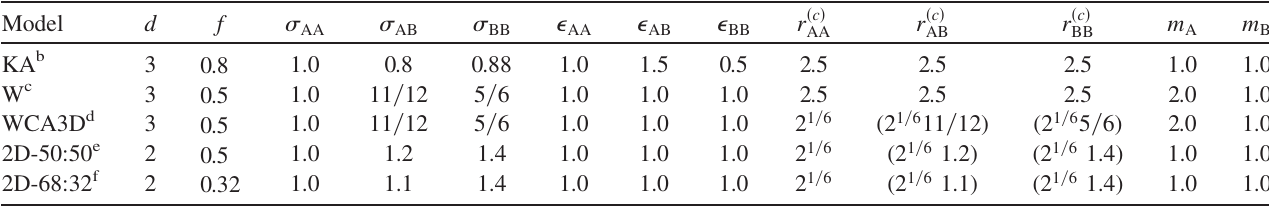
TABLE I. Parameters for model systems used in this study a